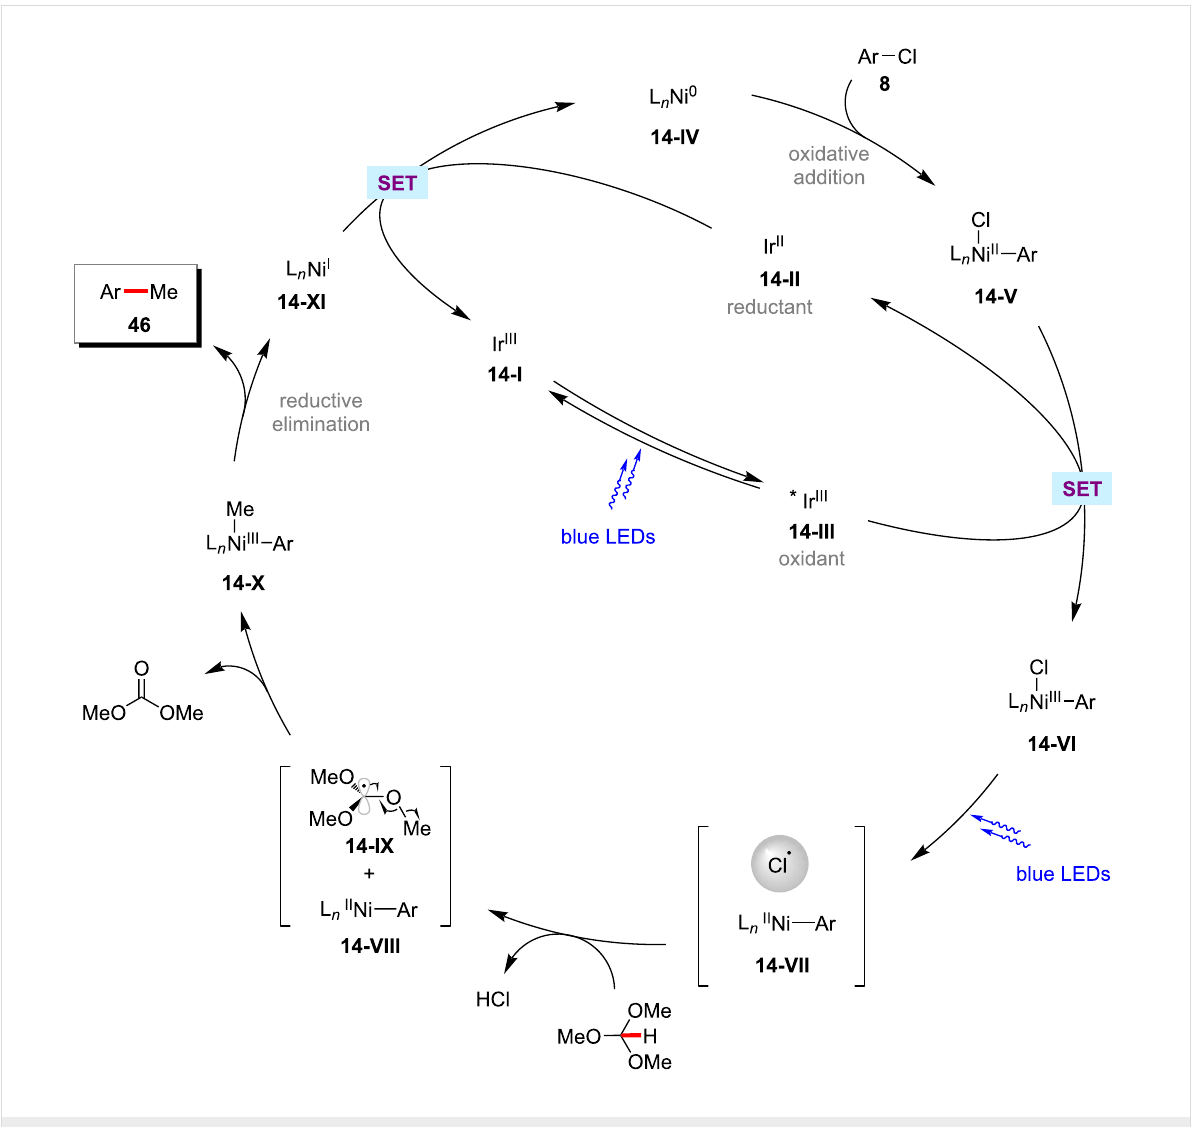
Figure 14: Proposed catalytic cycle for the nickel/photoredox-catalyzed methylation of (hetero)aryl chlorides using trimethyl orthoformate.